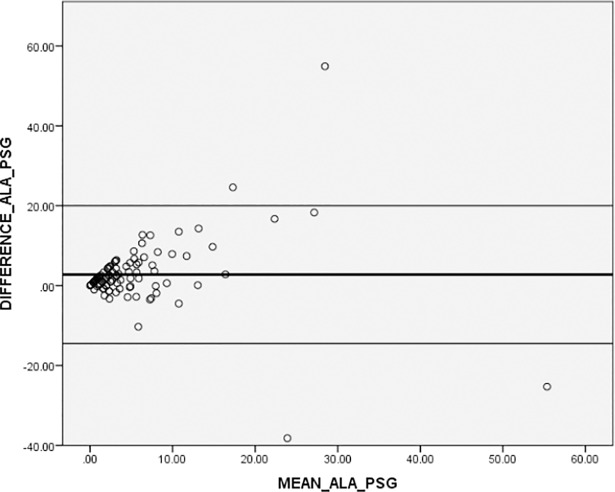
Bland-Altman plot illustrating the difference in AHI as measured from ApneaLinkTM autoscore versus PSG.Plots present differences between the two methods compared to mean AHI of the two methods. The black solid line represents the mean difference, the black thin lines the 95% confidence intervals on the limits of agreement. ALA, ApneaLinkTM autoscore; PSG, polysomnography.